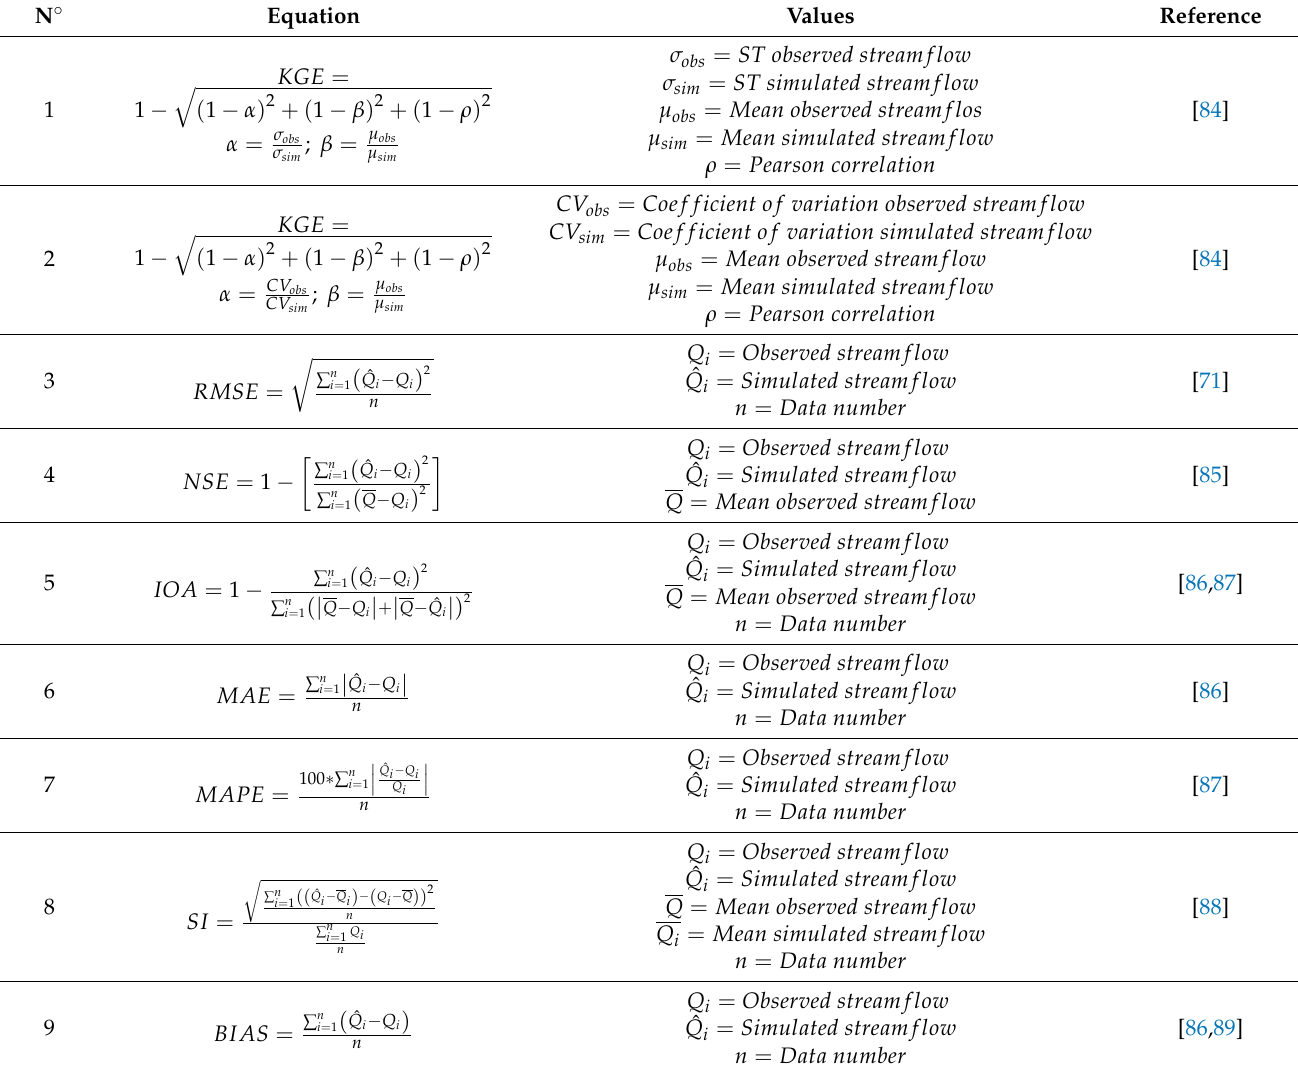
Table 2. Model efficiency